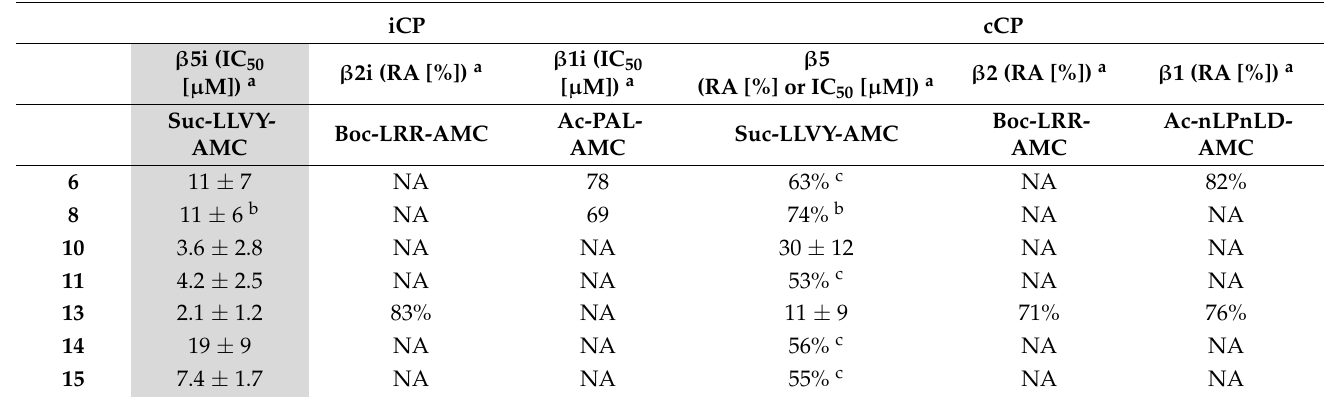
Table 3. Inhibitory potencies of selected compounds against other subunits ( β 2i and β 1i) of the human iCP and against all subunits ( β 5, β 2, β 1) of the human cCP. For β 1i, β 1, β 2i, β 2, and β 5, we measured RAs in the presence of 10 µ M of each compound. IC 50 values were determined only for compounds that showed notable inhibition at 10 µ M (RA < 60%). For β 5, carfilzomib was used as a control and exhibited RAs of 25 ± 1% at 10 nM. Bortezomib was used as a control for β 2i, β 1i, β 2, and β 1, and exhibited RAs (all at 10 µ M) of 16 ± 5%, 0%, 62 ± 9%, and 0%, respectively. Inhibitory activities of compounds against subunits β 5 and β 5i were measured using SDS as the proteasome activator, whereas for β 1, β i, β 2, and β 2i activities, PA28 α was used.